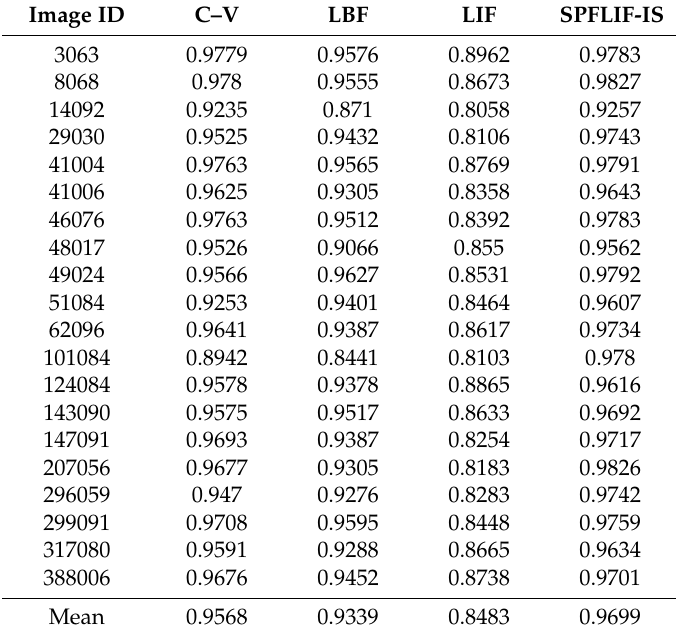
Table 6. DICE values of the image segmentation results using the four models for Berkeley color